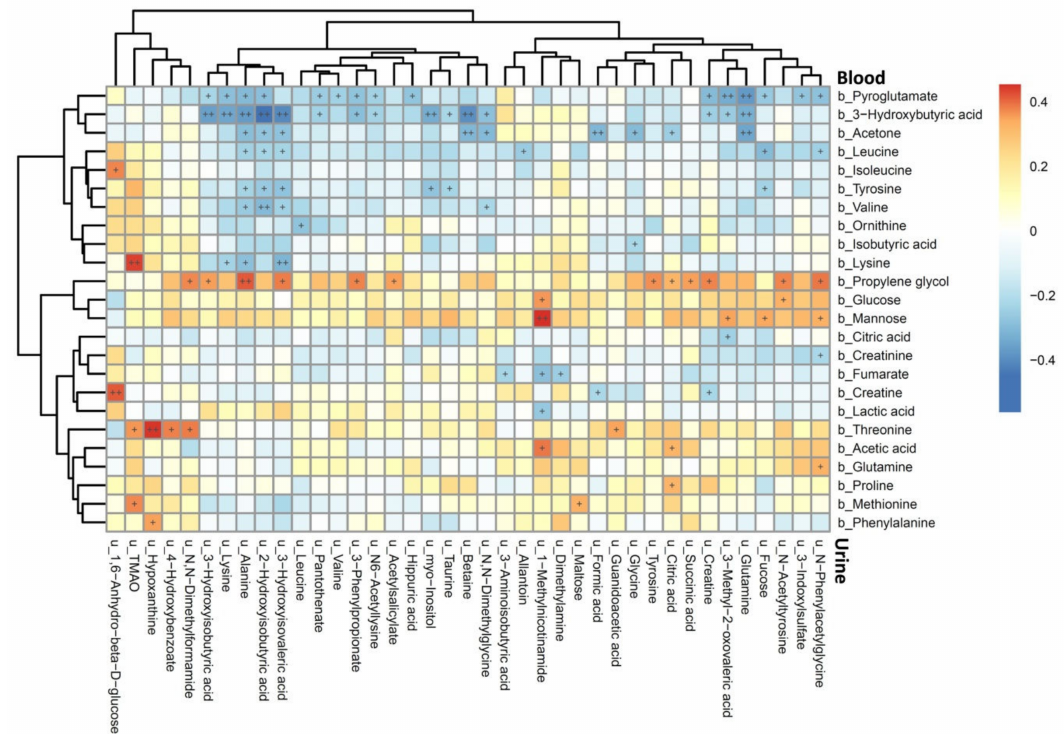
Figure 1. Heatmap of Spearman’s rank correlation coe ffi cients between plasma and urine metabolites. Color intensity represents the magnitude of correlation. Red color = positive correlations; blue color = negative correlations. + symbol means a p -value < 0.05; ++ symbol means a p -value <